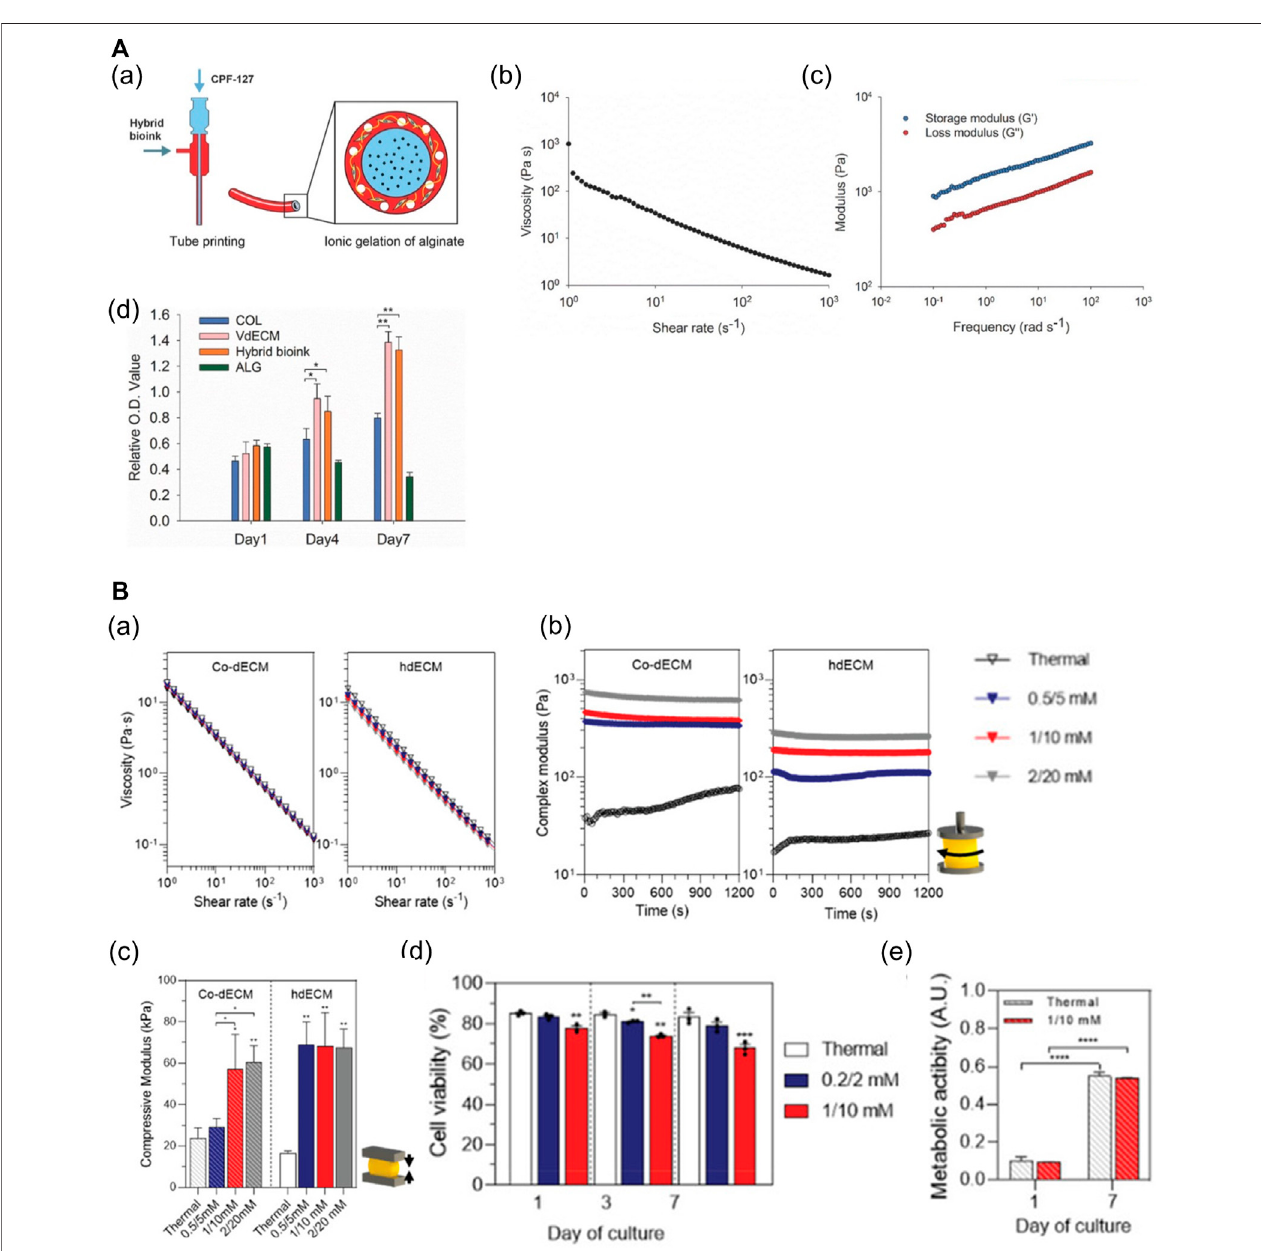
FIGURE 6 | dECM-based multicomponent bioinks. (A) Characteristics of hybrid bioink of VdECM and alginate. (a) Schematic depiction of the bio-blood vessel (BBV) printing using hybrid bioink with co-axial nozzle. (b) Shear-thinning behavior of the hybrid hydrogel. (c) The complex modulus of crosslinked hybrid bioink. (d) The proliferation rate of endothelial progenitor cells (EPCs) encapsulated in different types of bioinks (* p < 0.1, ** p < 0.01). Reproduced with permission from Gao et al. (2017). (B) Characteristics of dECM bioinks with Ru/SPS (dERS). (a) Shear-thinning behavior of two different dECM-based dERS bioinks (cornea dECM (co-dECM) and heart dECM (hdECM)). (b) The complex modulus of crosslinked dERS bioinks compared with dECM bioinks. (c) Improved mechanical properties of dERS bioinks after photocrosslinking and thermal crosslinking process. * p < 0.1, ** p < 0.01. (d) Cell viability of hiPSC- CMs embedded in the printed construct with hdECM-based bioinks at days 1, 3, and 7 (hdECM vs hdERS). (e) Metabolic activity of predifferentiated keratocytes in the printed construct with co-dECM bioinks at day 1 and day 7 (co-dECM vs co-dERS). *** p < 0.001. Reproduced with permission from Kim et al.